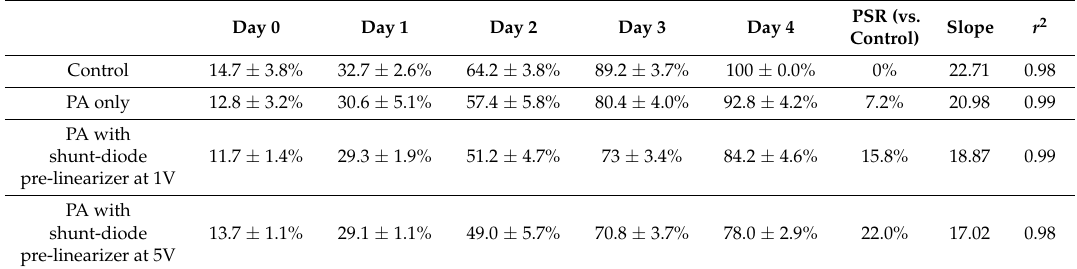
Figure 6. Measured HeLa cell densities when uncovered to the separated ultrasonic PA, PA with shunt-diode pre-linearizers at 1 V and at 5 V DC bias voltages from Day 0 to Day 4. PSR refers to proliferation suppressing ratio compared to the control group on Day 4. Table 2. Summary of the numerical experimental data of HeLa cell density results when using PA only, PA with or without shunt-diode pre-linearizer were applied individually.